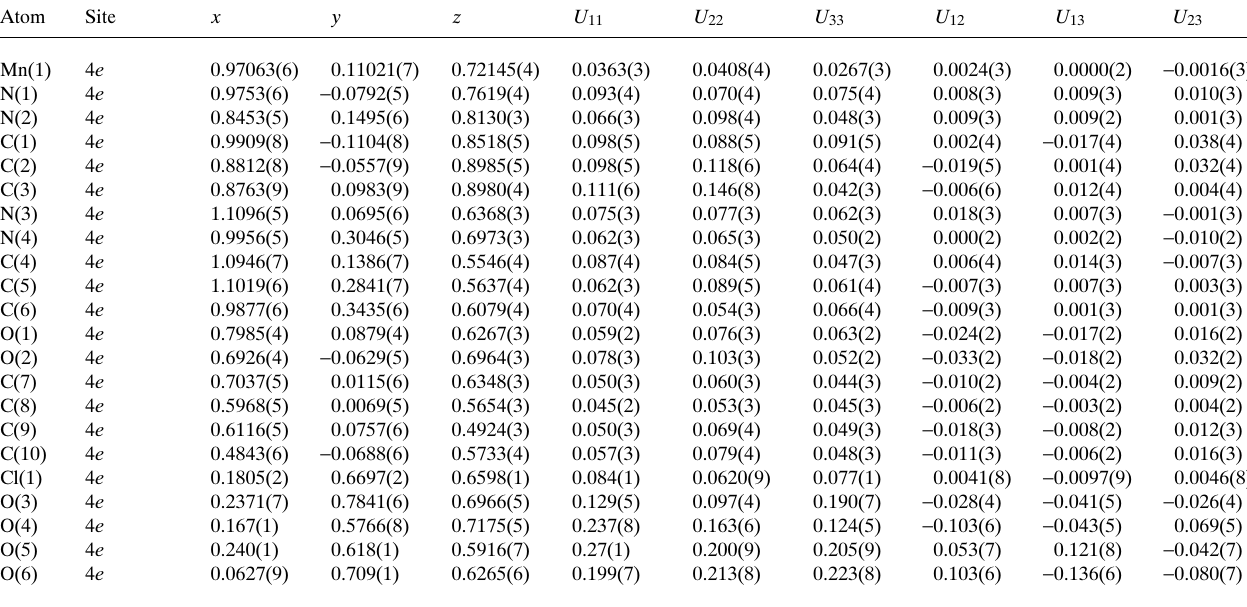
Table 3. Atomic coordinates and displacement parameters (in Å 2 ) .